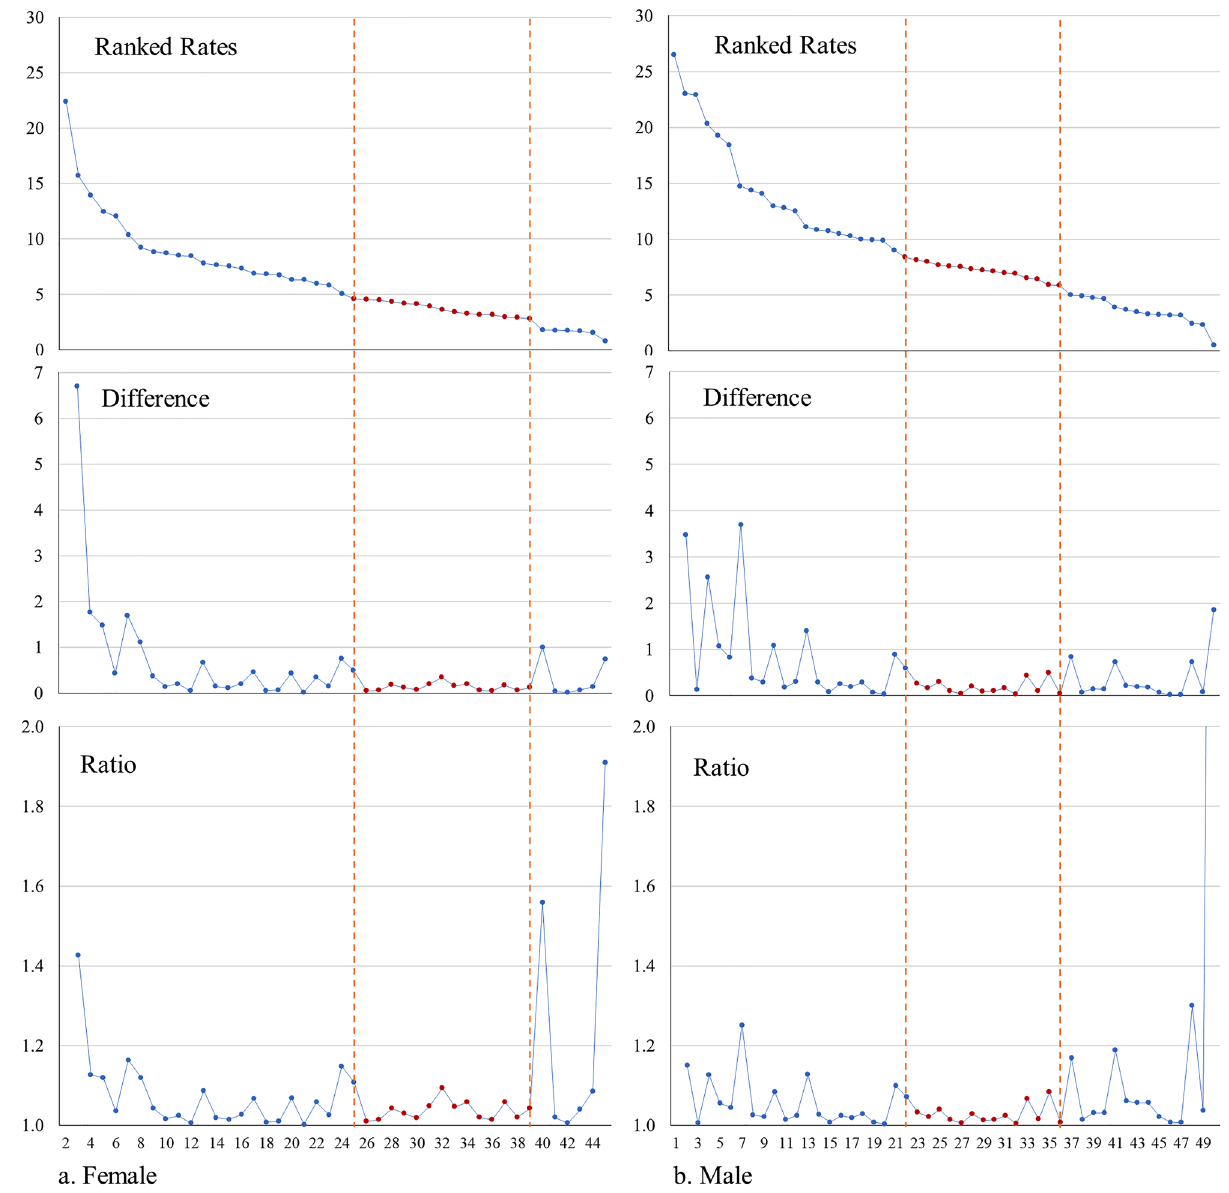
Figure 4. Plots of the ranked ALS incidence and the difference and ratio between two consecutive values. All plots are for the counties with non-zero incidence rates in Ohio.